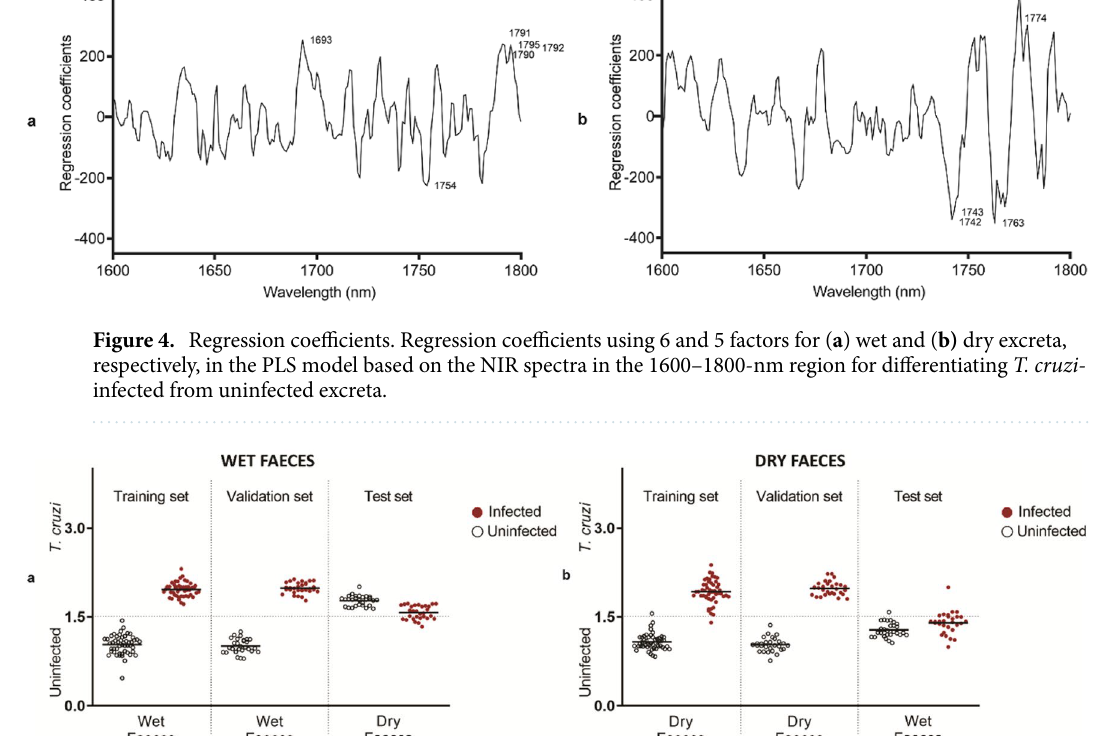
Figure 5. NIRS differentiation of T. cruzi -infected and uninfected excreta, using leave-one-out cross-validation analysis. Each circle represents an individual sample; infection status confirmed by PCR is indicated by red (infected) or empty (uninfected) circles. The lines indicate the mean prediction value for each group. The vertical axis indicates infection status as predicted by NIRS and was drawn by plotting the actual constituent values (1 = uninfected and 2 = infected), with the dotted line indicating the classification cut off point (1.5). Infected samples shown below the dotted line and uninfected samples shown above the dotted line were falsely predicted. ( a ) Wet faeces model. ( b ) Dry faeces